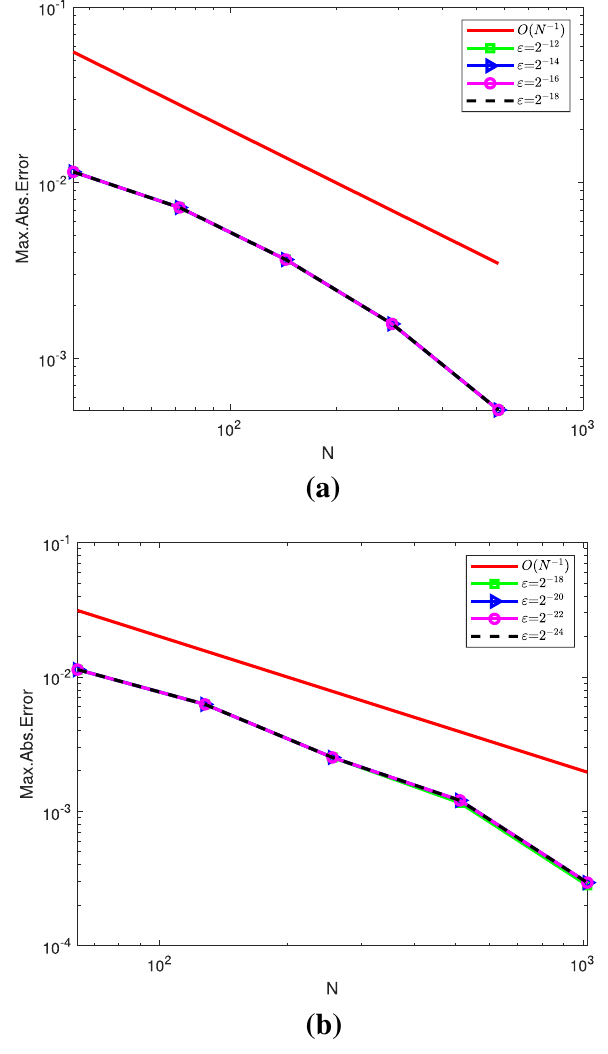
Fig. 5 Log–log plots of maximum absolute error verses N with dif- ferent values of 𝜀 for ( a) Example 1 and (b) Example